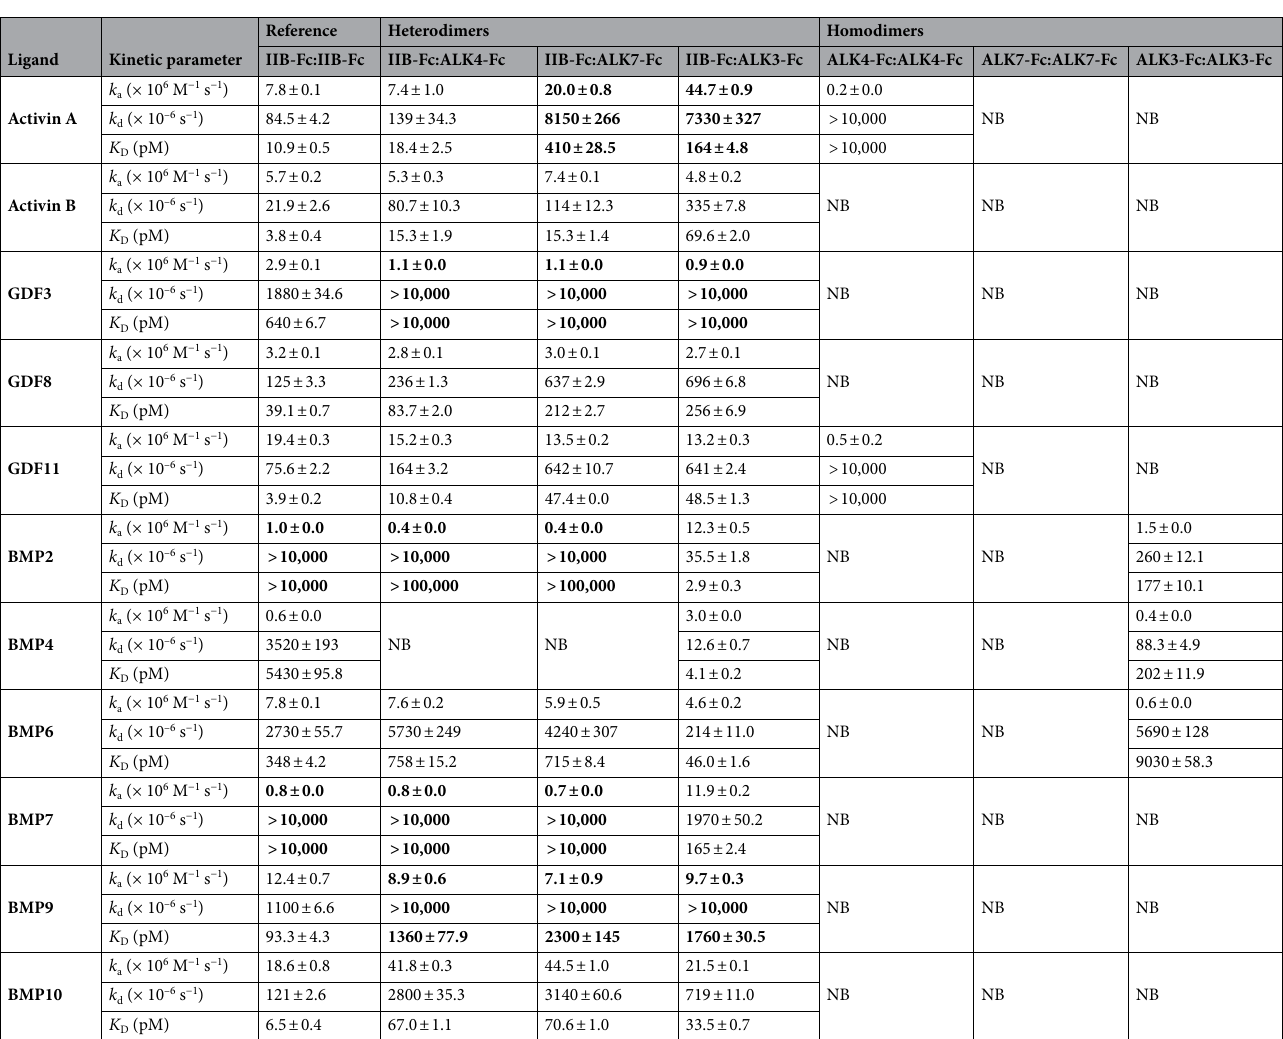
Table 1. Kinetic parameters of ligand binding by Fc-fusion protein constructs as determined by SPR. Values are means ± SEMs (n = 3 independent experiments). NB, no binding. Bold cells indicate values obtained